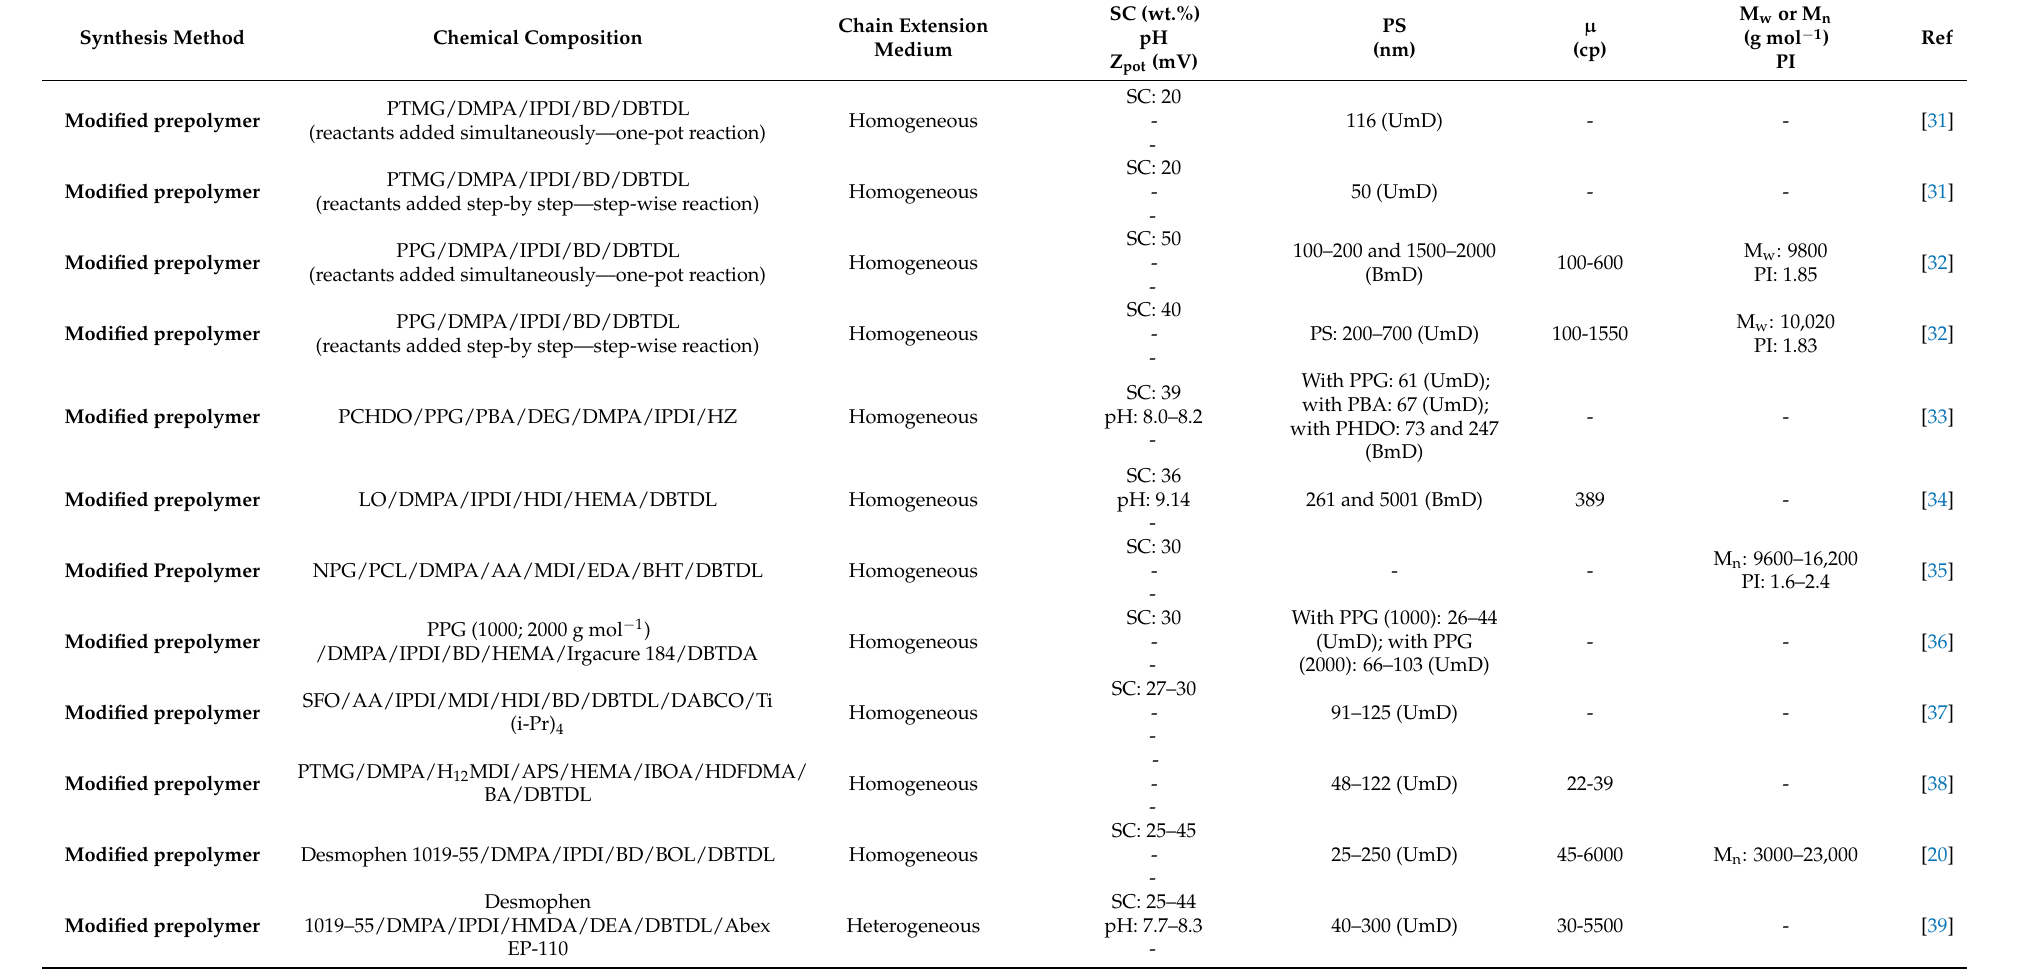
Table 1. Effect of WBPU and WBPUU synthesis methods and composition on dispersion’s properties: chain extension medium (homogeneous or heterogeneous), solids content (SC), pH, zeta potential (Z pot ), average particle size (PS) (Unimodal distribution (UmD), Bimodal distribution (BmD)), viscosity ( µ ), weight average molecular weight (M w ), number average molecular weight (M n ), and polydispersity index